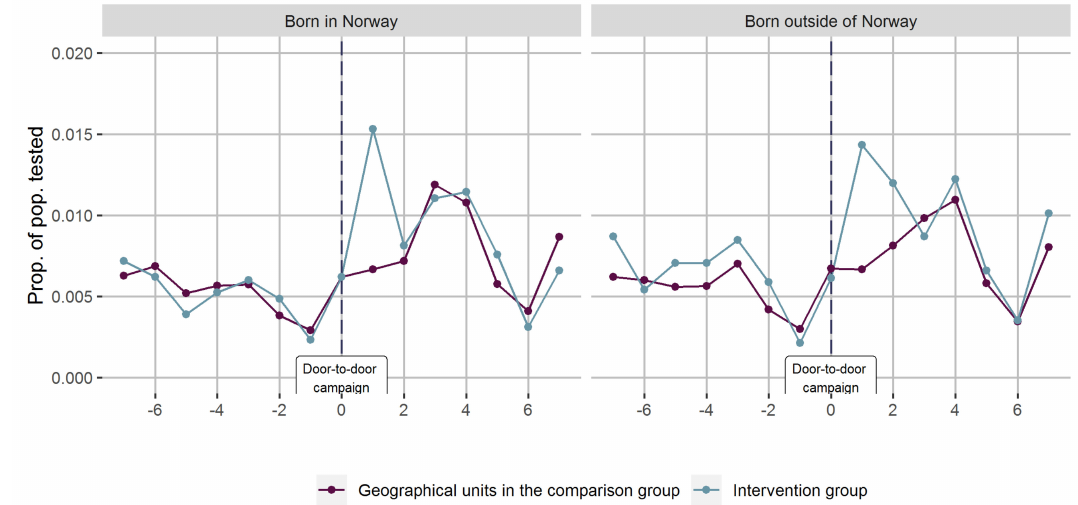
Figure 5. Joint proportions of the population tested for COVID-19 in geographical units with and without door-to-door campaigns promoting COVID-19 testing (day 0) accompanied mobile testing facilities from, in total, three interventions, stratified by Norwegian and